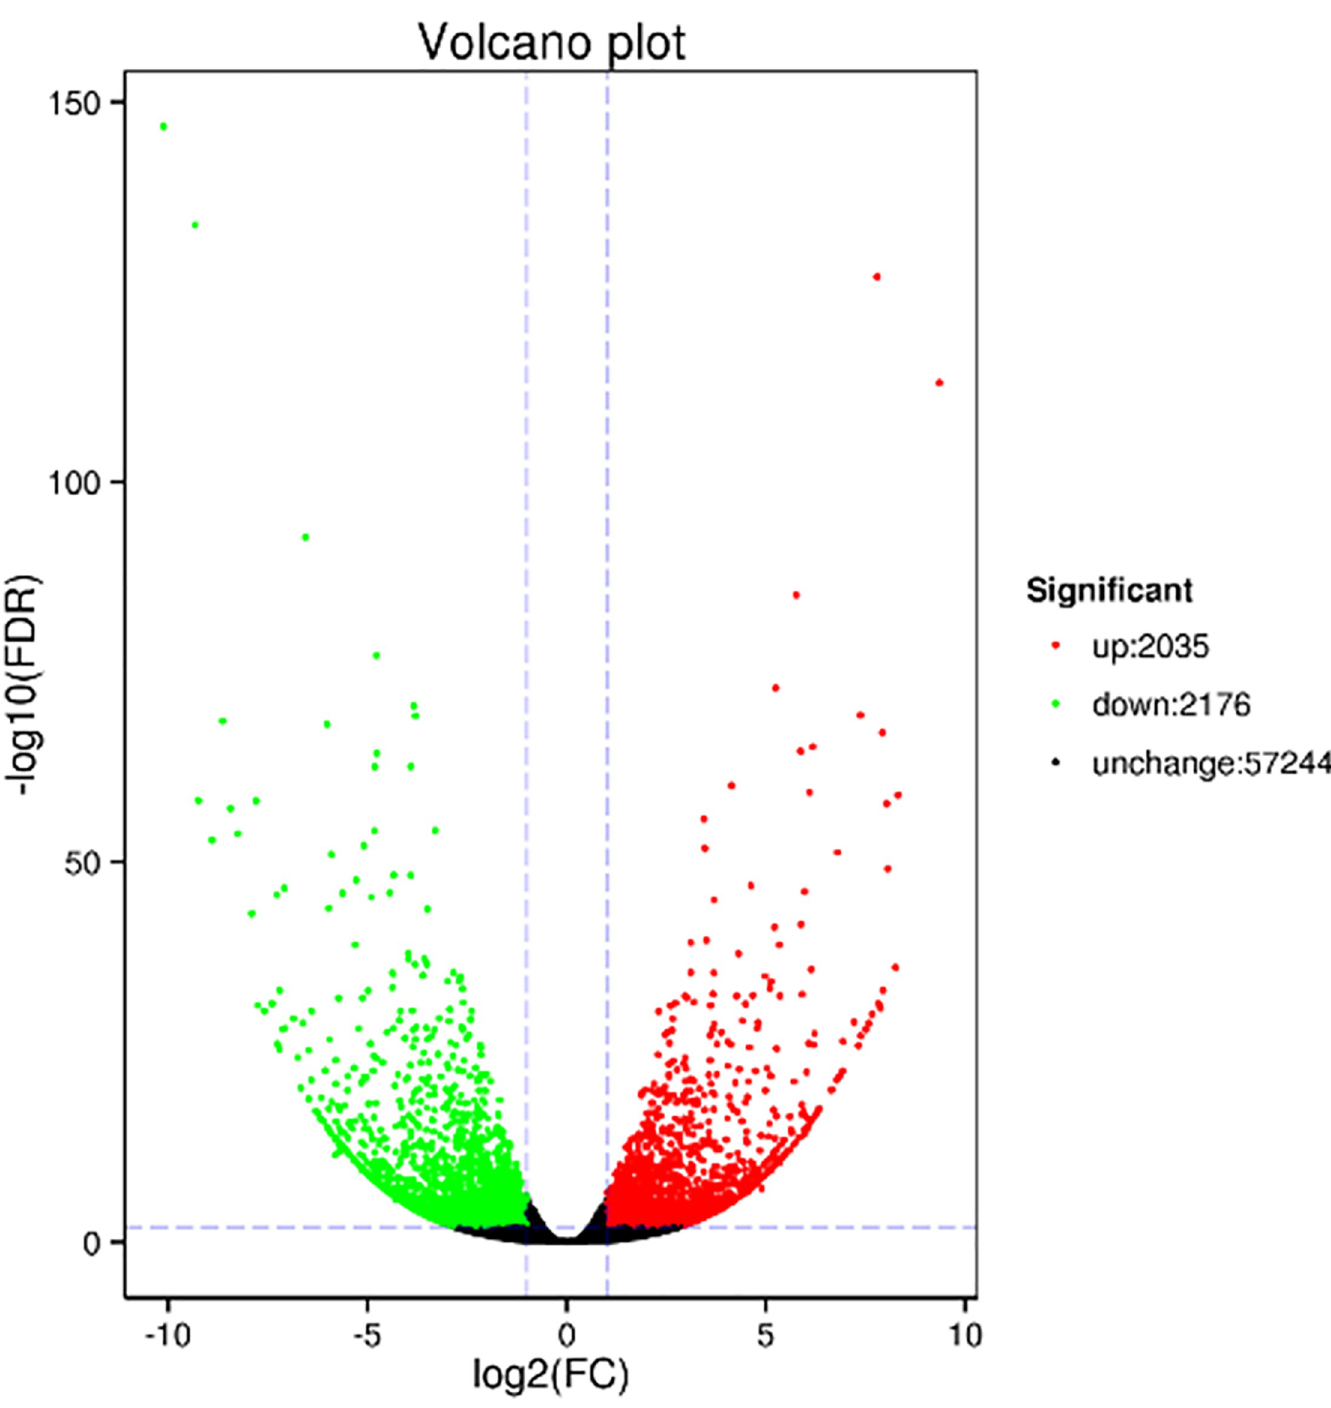
Fig 4. Volcano plot of differentially regulated genes in PL vs RG. The red dots are upregulated genes and green dots are downregulated genes. https://doi.org/10.1371/journal.pone.0230154.g004 subjected to Pearson correlation analysis (Fig 8). There were 141 significant correlation combi- nations between the genes and metabolites that had a Pearson correlation coefficient > 0.8 and p value < 0.05.